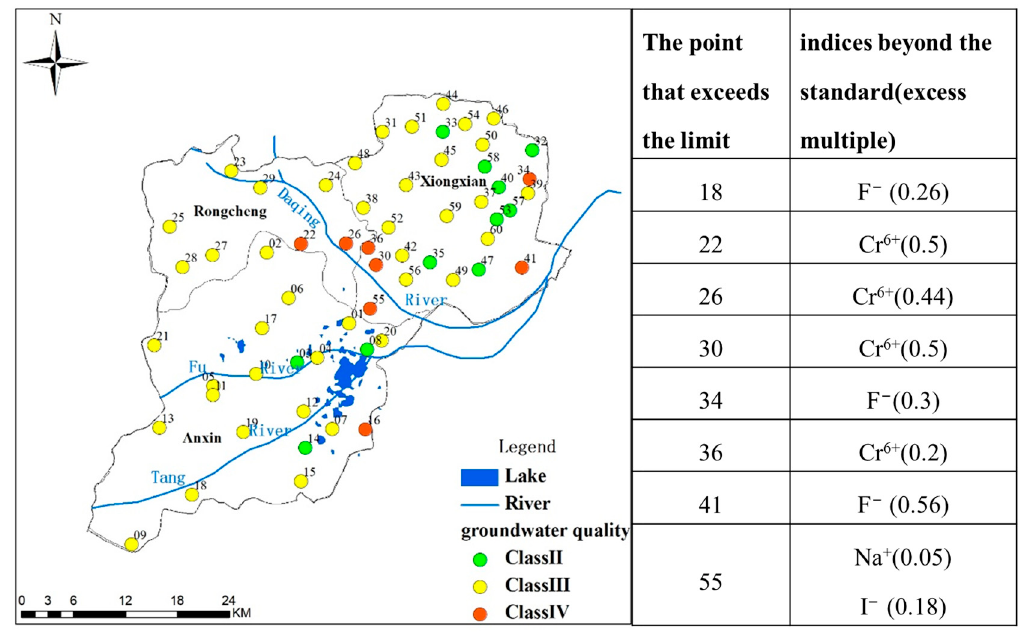
Figure 3. Distribution of water quality categories in the study area.